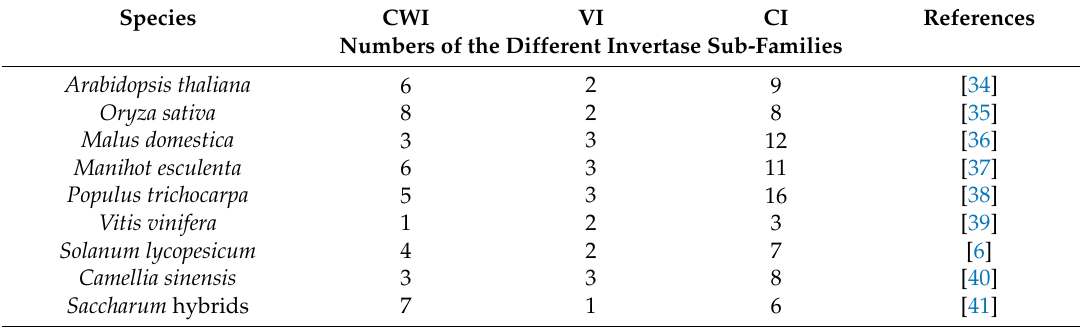
Table 1. Numbers of identified invertase genes within different plant